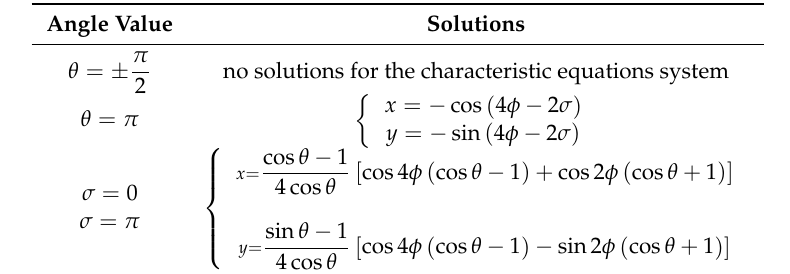
Table 2. Kinematic equations of the Tripod mini-manipulator for possible working conditions; x and y refer to the coordinates of the V